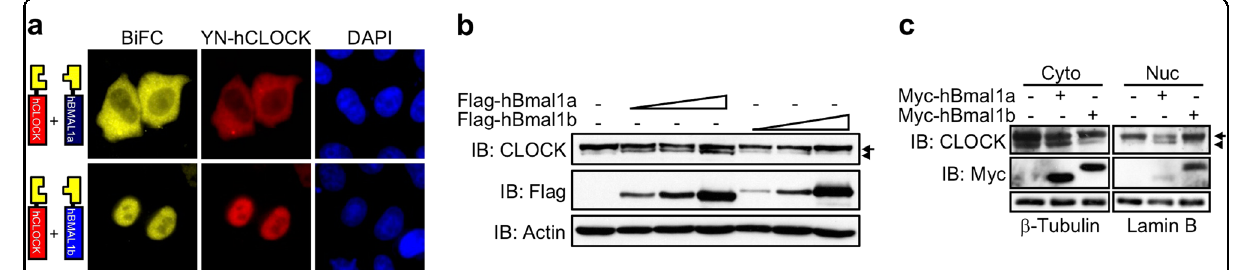
Fig. 2 Cytoplasmic retention of hCLOCK by hBMAL1a. a Direct interactions between hBMAL1 isoforms and hCLOCK were visualized by the BiFC assay. YN-hClock was co-transfected with YC-hBmal1a or YC-hBmal1b into HeLa cells. The subcellular localization of hCLOCK was detected by immuno fl uorescence staining using an anti-CLOCK antibody. b The expression of the endogenous hCLOCK was determined by western blotting in the presence of different levels of either Flag-hBMAL1a or hBMAL1b. c HeLa cells transfected with either Myc-hBmal1a or Myc-hBmal1b were subjected to nucleocytoplasmic fractionation. The level of hCLOCK in each fraction was analyzed by western blotting using an anti-CLOCK